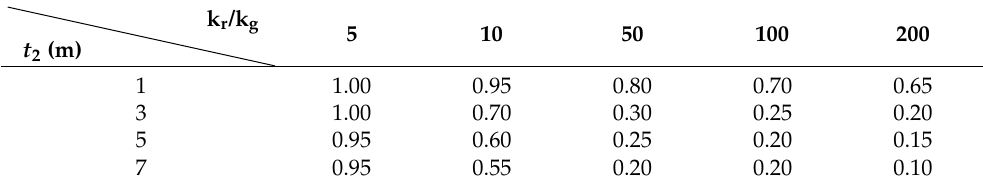
Table 5. Recommended value of water pressure reduction coefficient of class B surrounding rock.